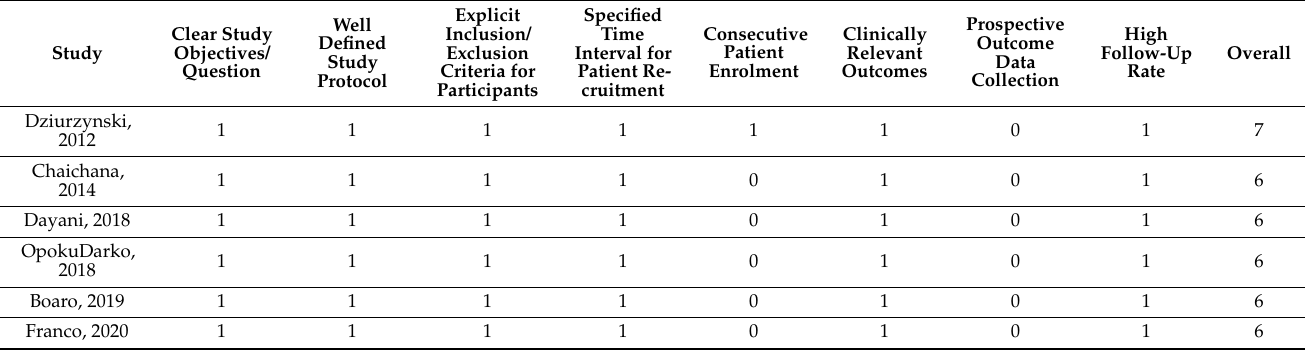
Table A2. Quality assessment performed by authors using the questionnaire by Chan and